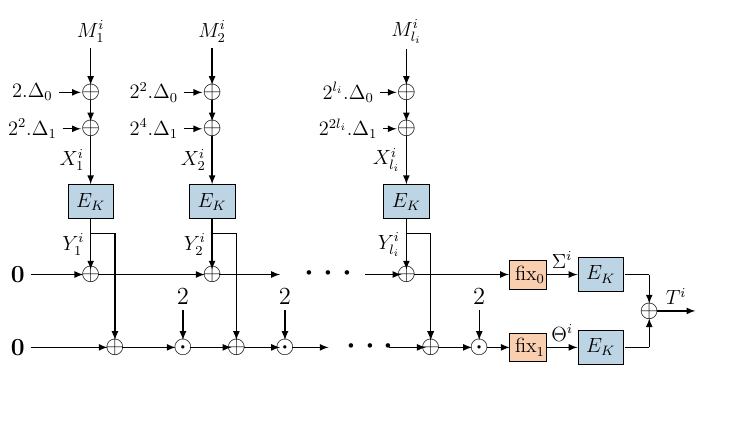
Figure 4.1: 1k-PMAC_Plus Construction.